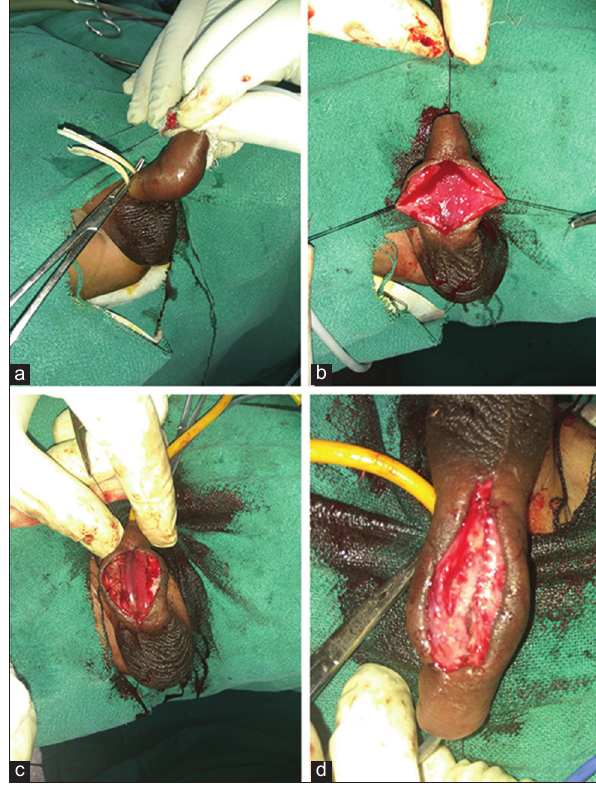
Figure 1: (a) Ballooned congenital megalourethra. (b) Ventral midline incision without degloving. (c) Redundant urethra excision. Cover of corpora spongiosum and